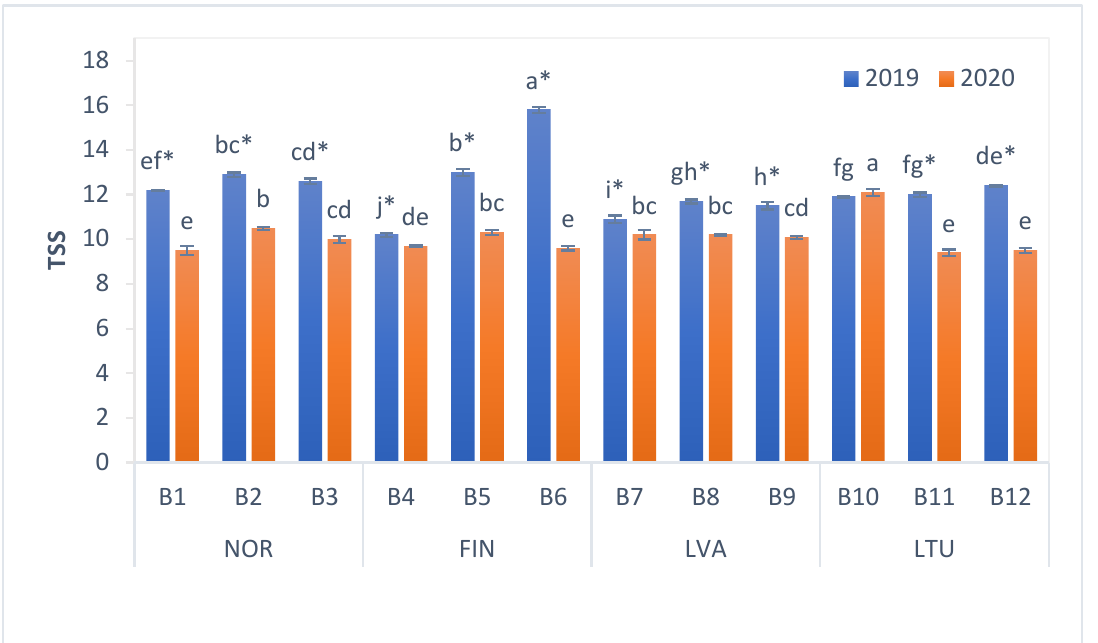
Figure 1. pH values of bilberries. Values are presented as means ± standard deviations. Different letters within the same column indicate significant differences between the collection locations (B1–B12) ( p < 0.05). Significant differences between 2019 and 2020 are indicated by asterisks (*) ( p < 0.05). Locations of bilberry sample collection include Norway (NOR), Finland (FIN), Latvia (LVA) and Lithuania (LTU).